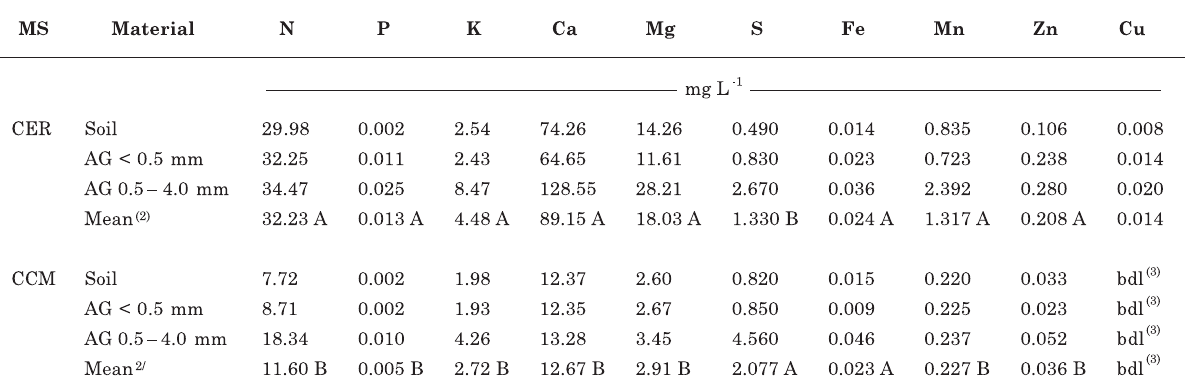
Table 3. Nutrient concentration in the soil solution, considering the material used for testing, soil or aggregates (AG), and the management system (MS)